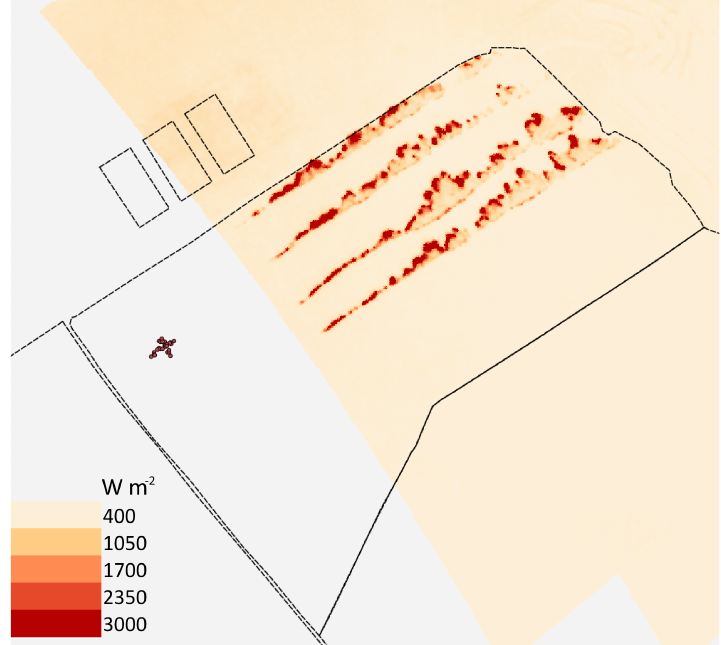
Figure 1. Long wave infra-red (LWIR) image of L2G lot during ignition (12:32:02 CST) with dashed black lines denoting burn perimeters. Red scatter points correspond to Highly Instrumented Plot (HIP) #1 fire behavior packages (FBP), each containing a system of airflow, temperature and energy